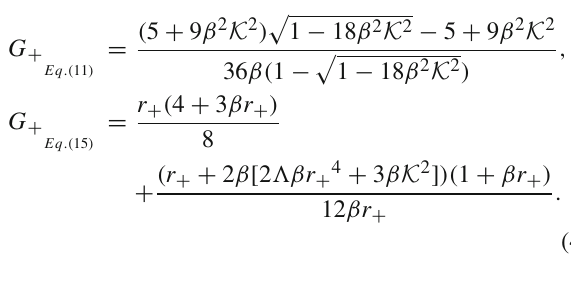
( a ) Entropy of the black hole solution (11) (b) Entropy of the black hole solution (15) Fig. 4 Schematic plot of the entropy of the two black holes (11) and (15) versus the dimensional parameter β